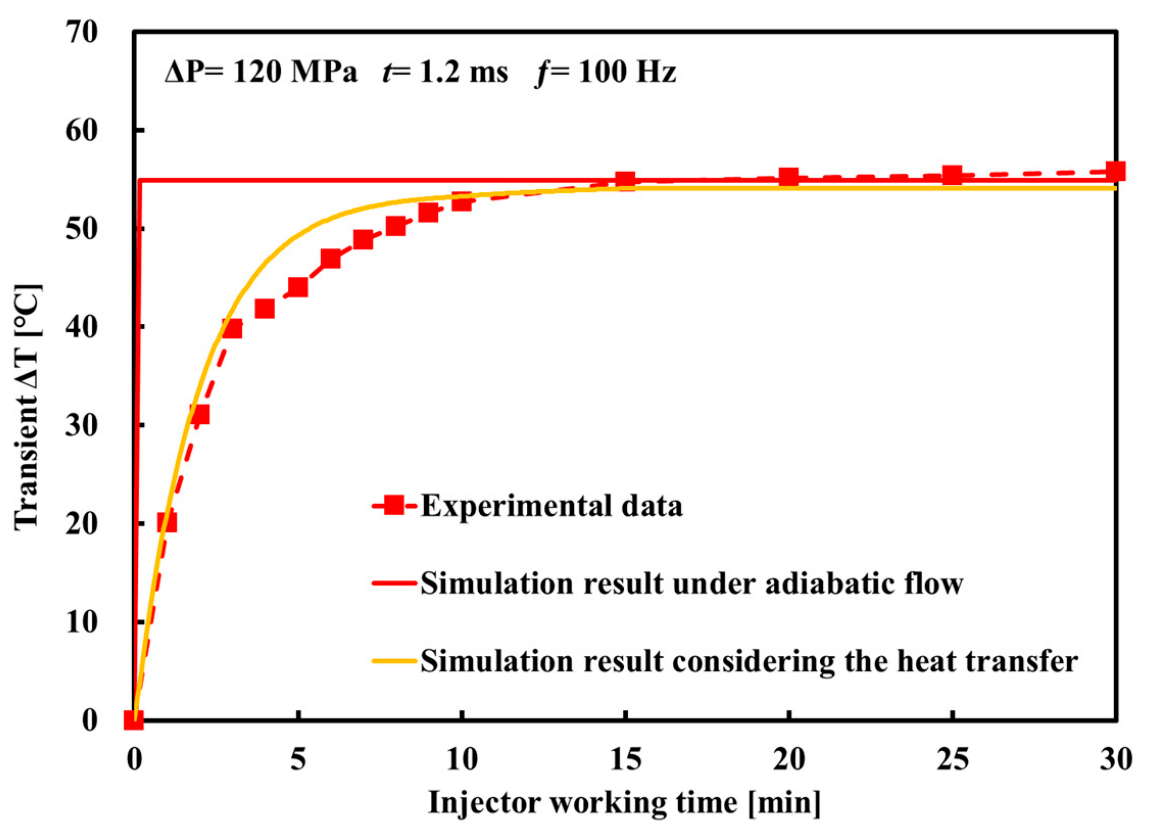
Figure 10. Comparison of the ∆ T calculation results under non-isothermal flow coupled with heat transfer process and adiabatic flow with experimental data.